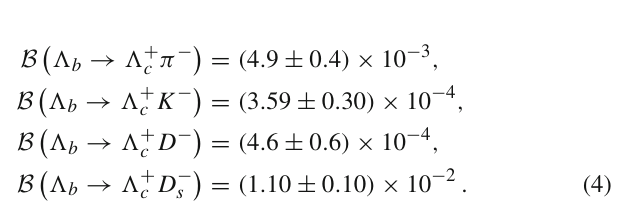
and the decay branching ratios of (cid:2) b → (cid:2) + observed as